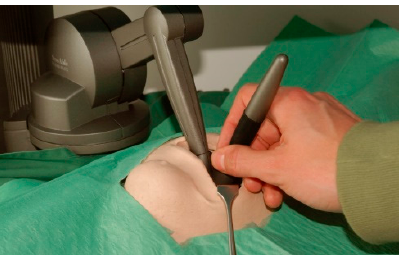
Figure 2. The haptic device of the Kobra simulator as used in virtual surgery.